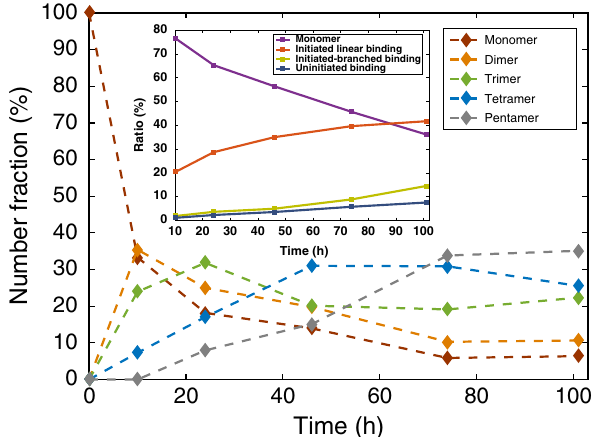
Fig. 4 The evolution of the distribution of assembled chains of various lengths. Each data point is the ratio of the number of initiators in chains of a certain length to the total number of initiators from the analysis (see Supplementary Tables 1 and 2 for the counting results). Each curve demonstrates the change of the number fraction of the assembled structures of a certain length with time. This group of curves presents the majority of the assembled structures in the system progress from monomers to dimers, trimers, tetramers, and fi nally pentamers. The inset shows the proportions of droplets staying as unbound monomers, with initiated linear (only one predecessor and one successor) and branched (multiple predecessors or successors) bindings, as well as non-speci fi c bindings at different time points. The droplets with non-speci fi c bindings account for the ones in wrong sequences (e.g., A — C, B — E or D — D, etc.) or uninitiated assemblies (e.g., B — C or C — D — E,